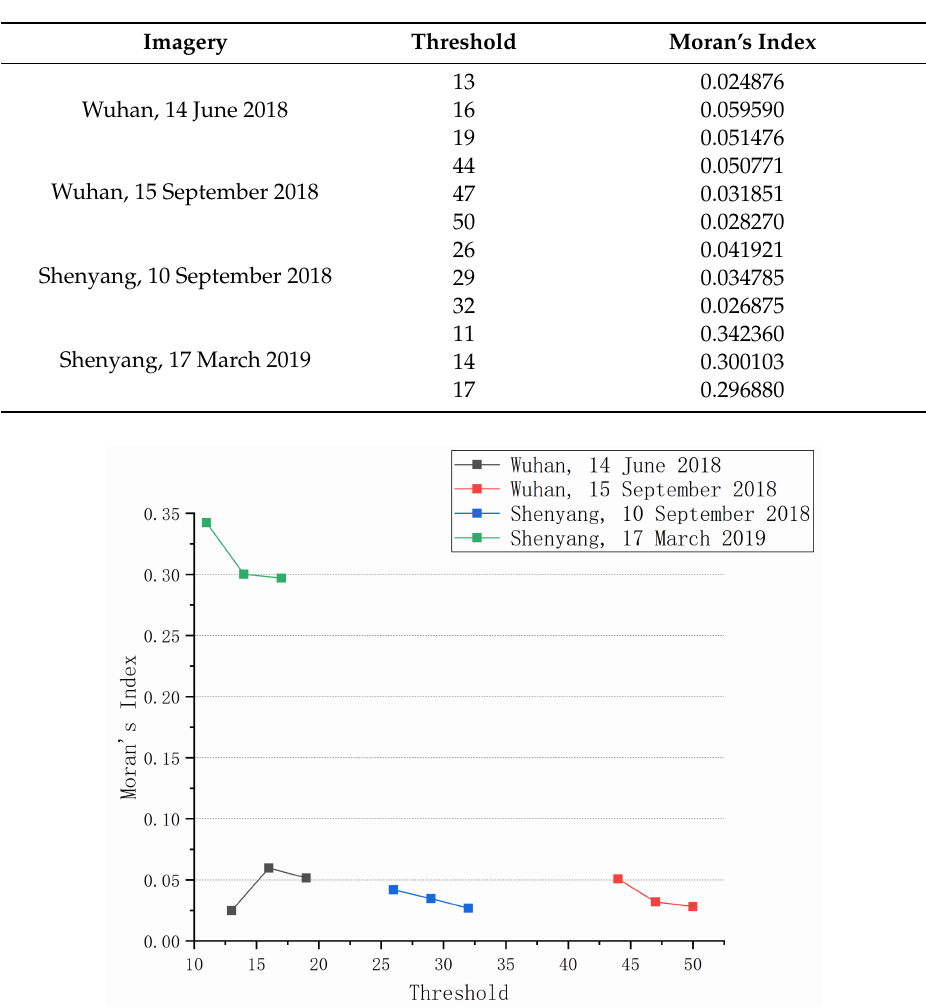
Table 6. The Global Moran’s I with di ff erent thresholds.